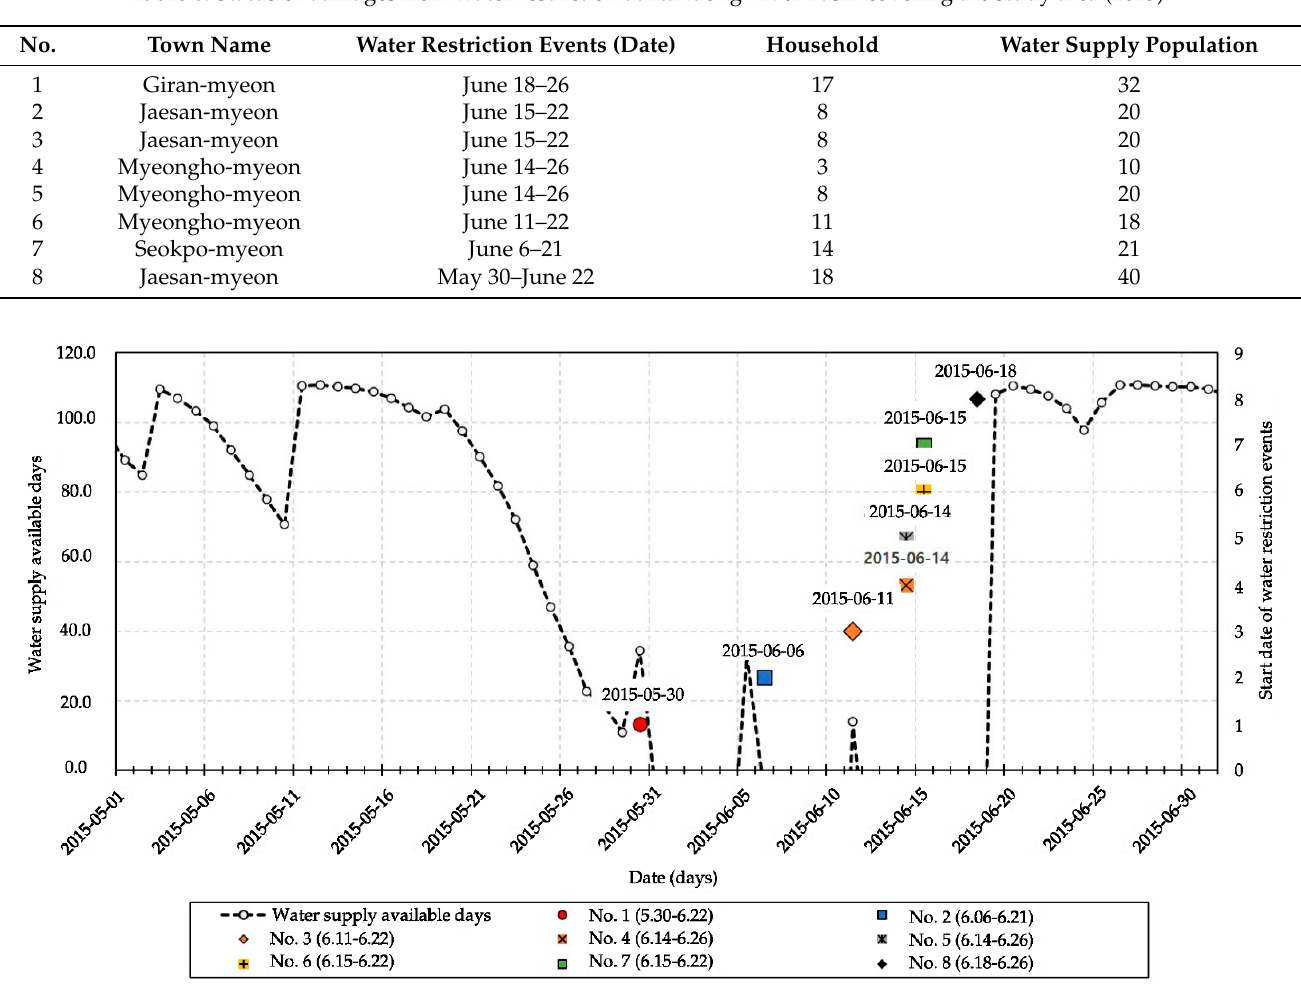
Figure 14. Comparison of water supply available days and start date of water restriction events of Yecheon Basin (1 May to 1 July 2015).